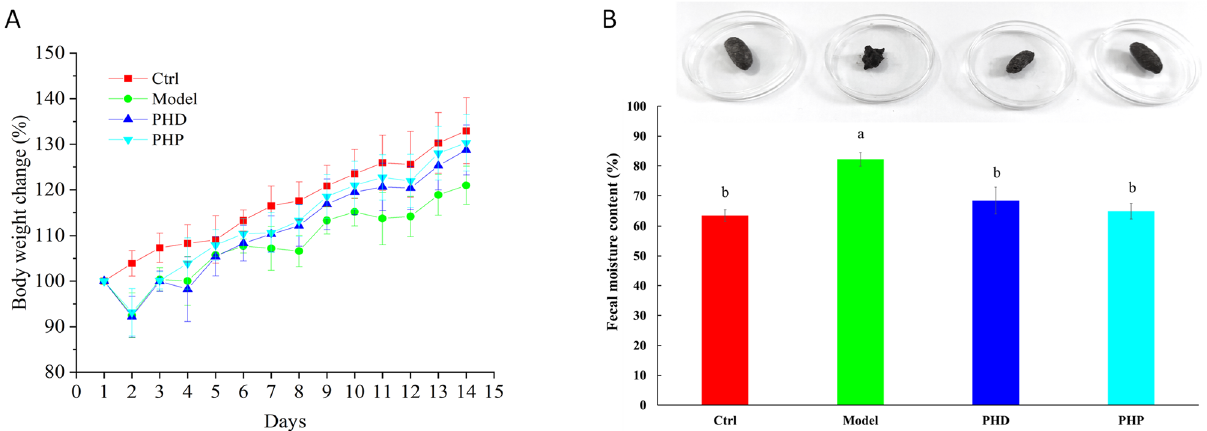
Figure 2. Effect of PHD and PHP on body weight of rats ( A ) and fecal moisture content ( B ). Values was presented as mean ± SD (n = 5). Significant differences ( p < 0.05) were determined by one-way ANOVA and